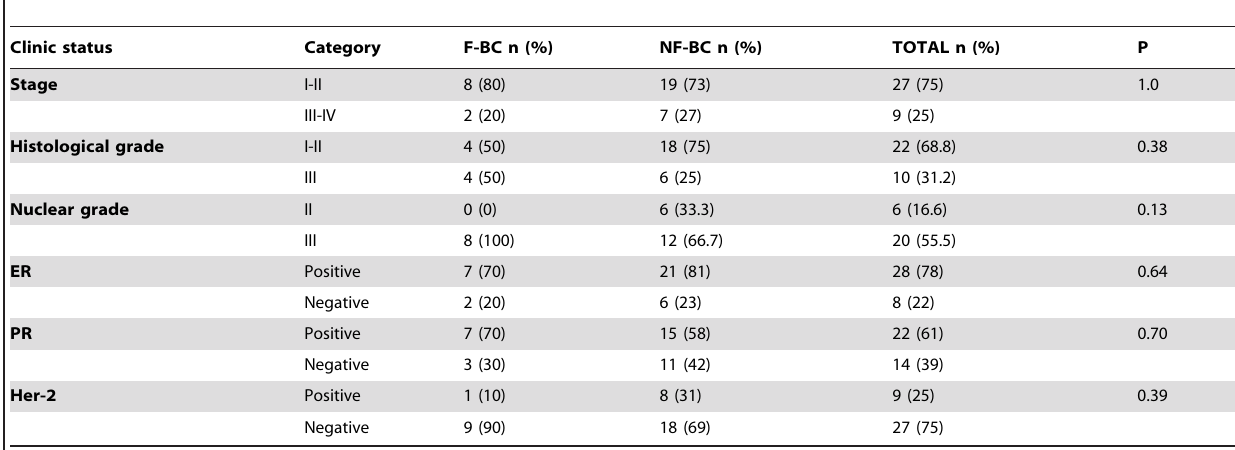
Table 2. Frequency of clinical and histopathological characteristics according to the groups—familial breast cancer (F-BC) and sporadic breast cancer (NF-BC).